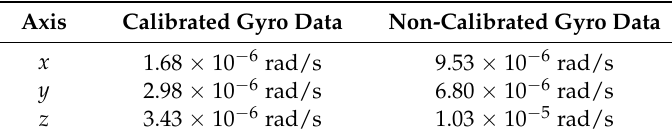
Figure 10. Input data of the TCZUPT filter. Table 5. Mean value of residuals of the moving